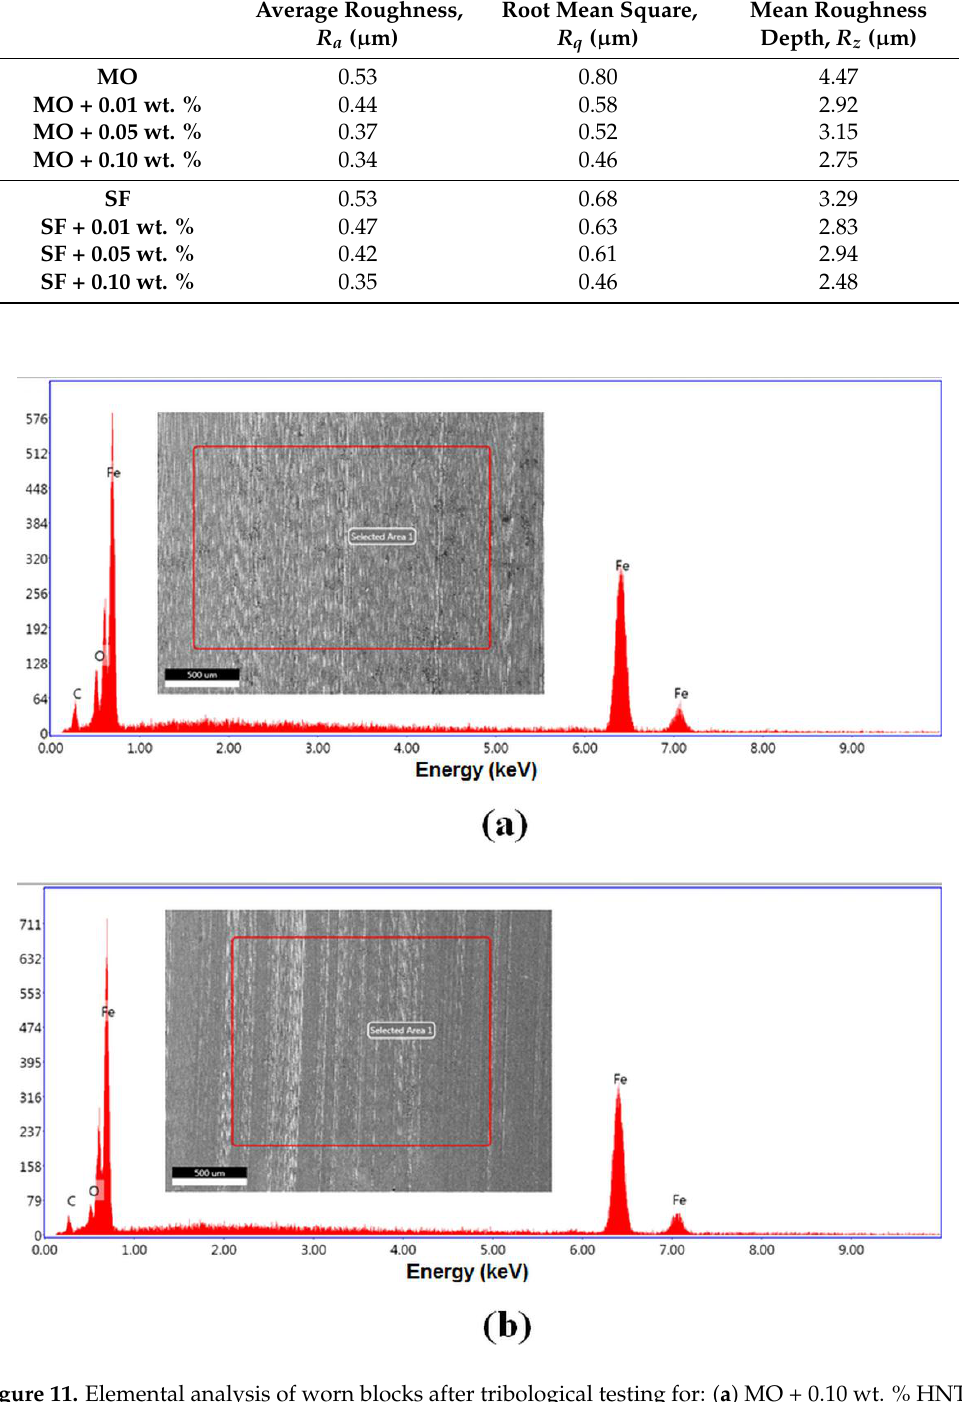
Figure 11. Elemental analysis of worn blocks after tribological testing for: ( a ) MO + 0.10 wt. % HNTs, and; ( b ) SF + 0.10 HNTs.